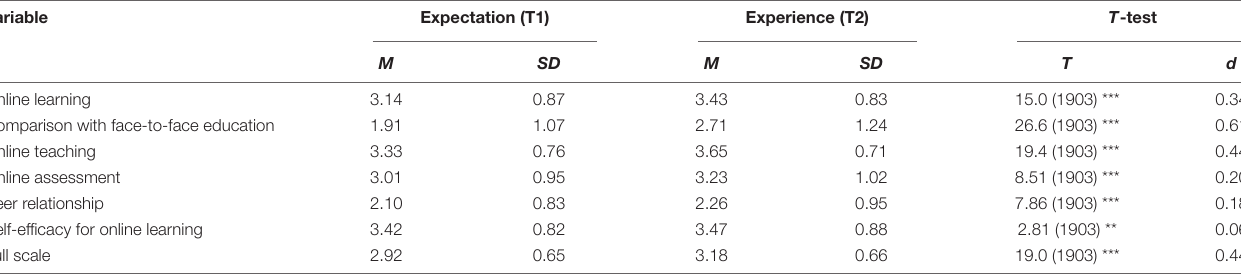
TABLE 3 | Descriptive and inferential statistics on students’ expectations and experiences during the ERT.